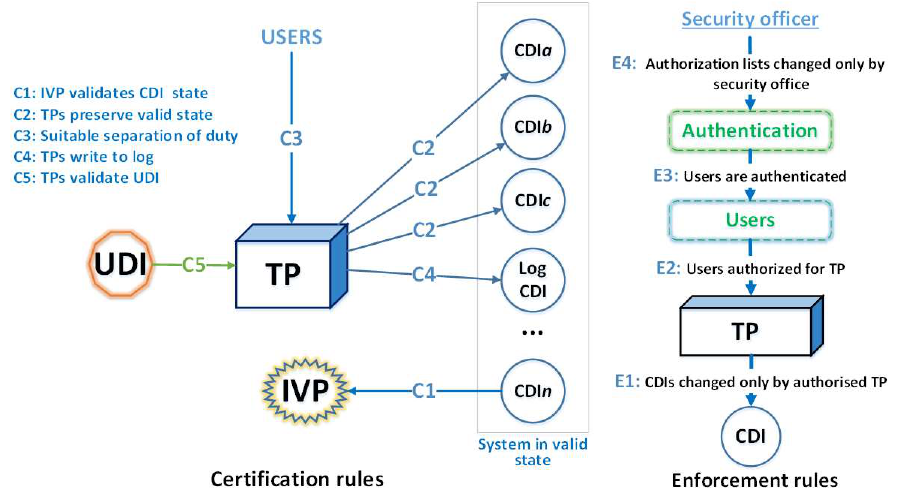
Figure 2. Scheme of applying the rules of the Clark–Wilson